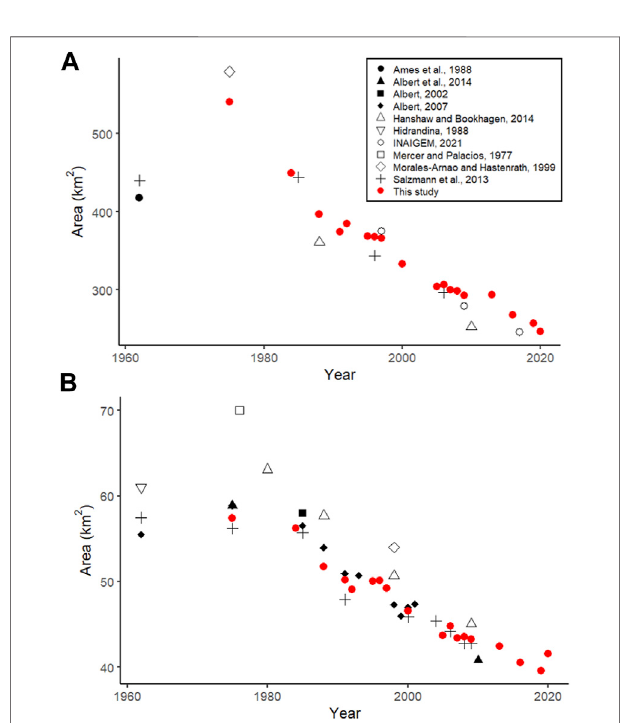
Frontiers in Earth Science |